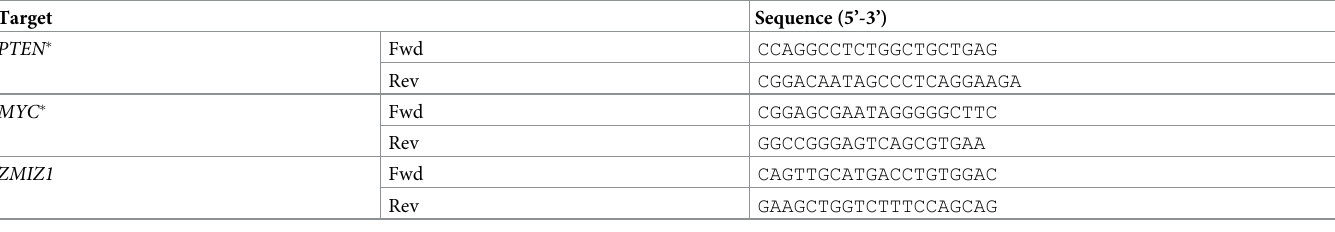
Table 2. Oligo sequences for T7EI assay for PTEN , MYC and ZMIZ1 .